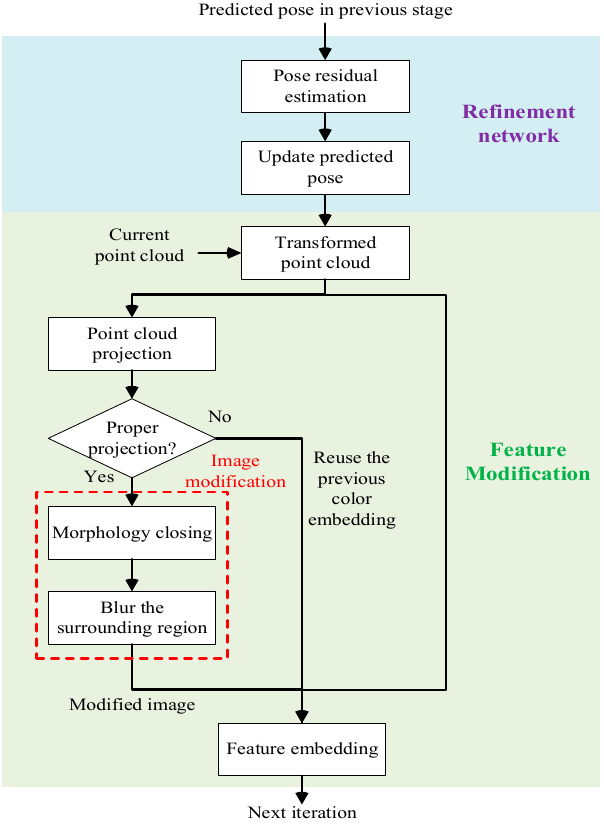
Figure 2. The proposed iterative pose refinement process.